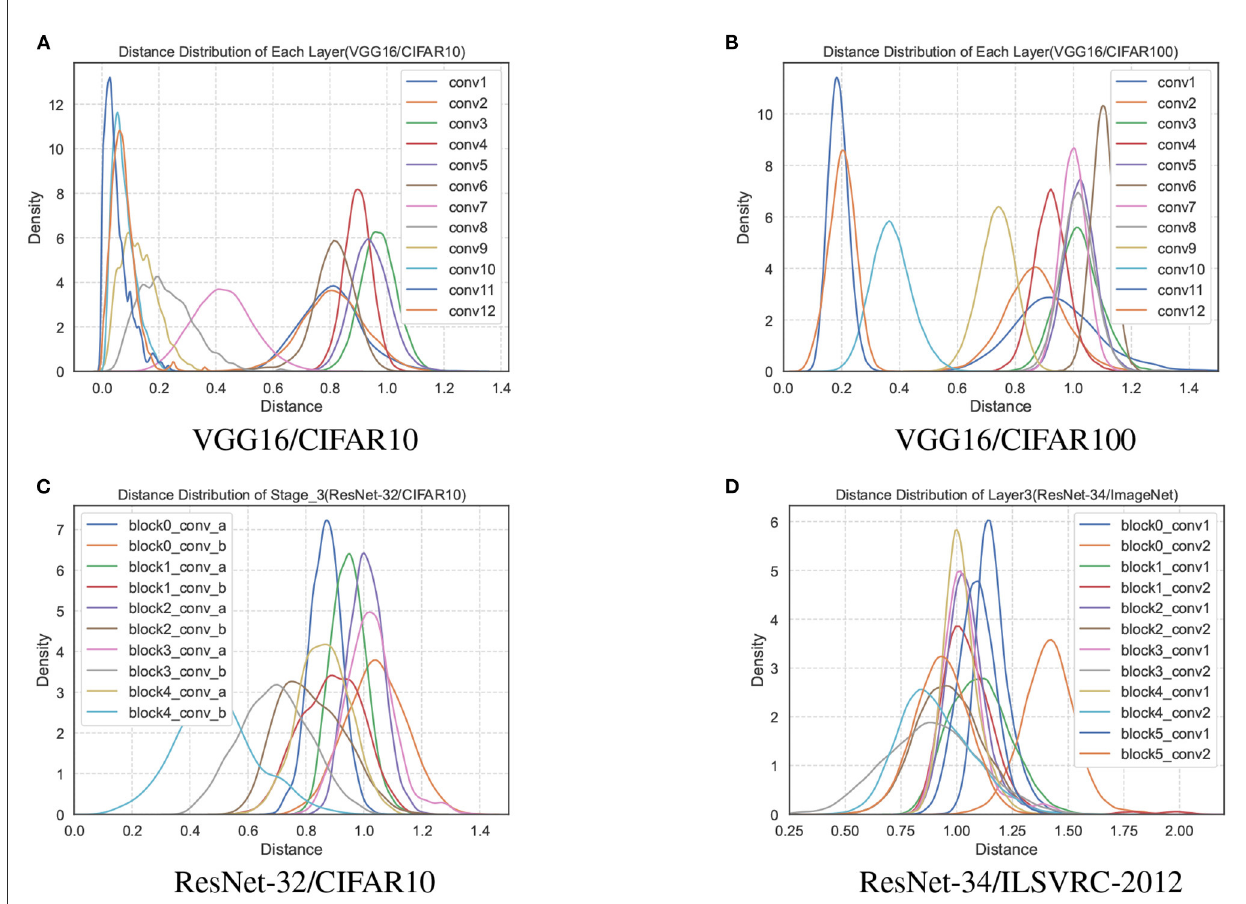
FIGURE2 The distance distributions of each layer of the network model parameters trained by VGG16 on the CIFAR10 and CIFAR100 datasets are shown in (A, B) . (C) The distance distribution of all convolutional layers in the third stage of ResNet-32/CIFAR10. (D) The third layer of ResNet-34/ILSVRC-2012.